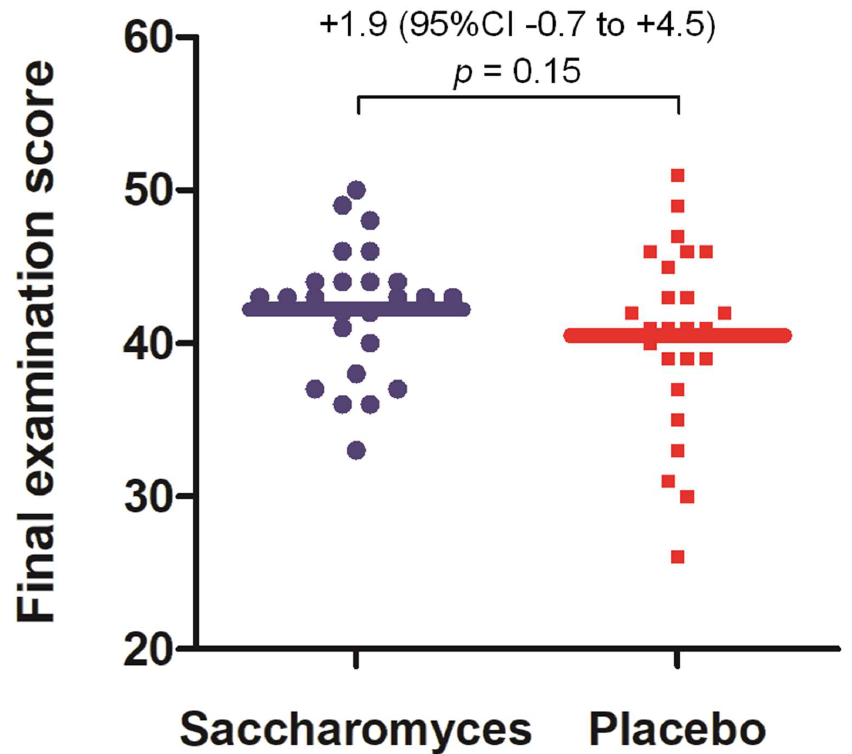
Figure 3. Primary outcome measure: final examination scores. A per protocol analysis is presented. Individual data points are marked. The mean scores are represented by horizontal lines. The effect sizes of the difference in the scores together with a p -value for the comparison are reported above the graph. The analysis is presented after adjusting for the results of the preexamination test in pharmacology held a day before the final examination.